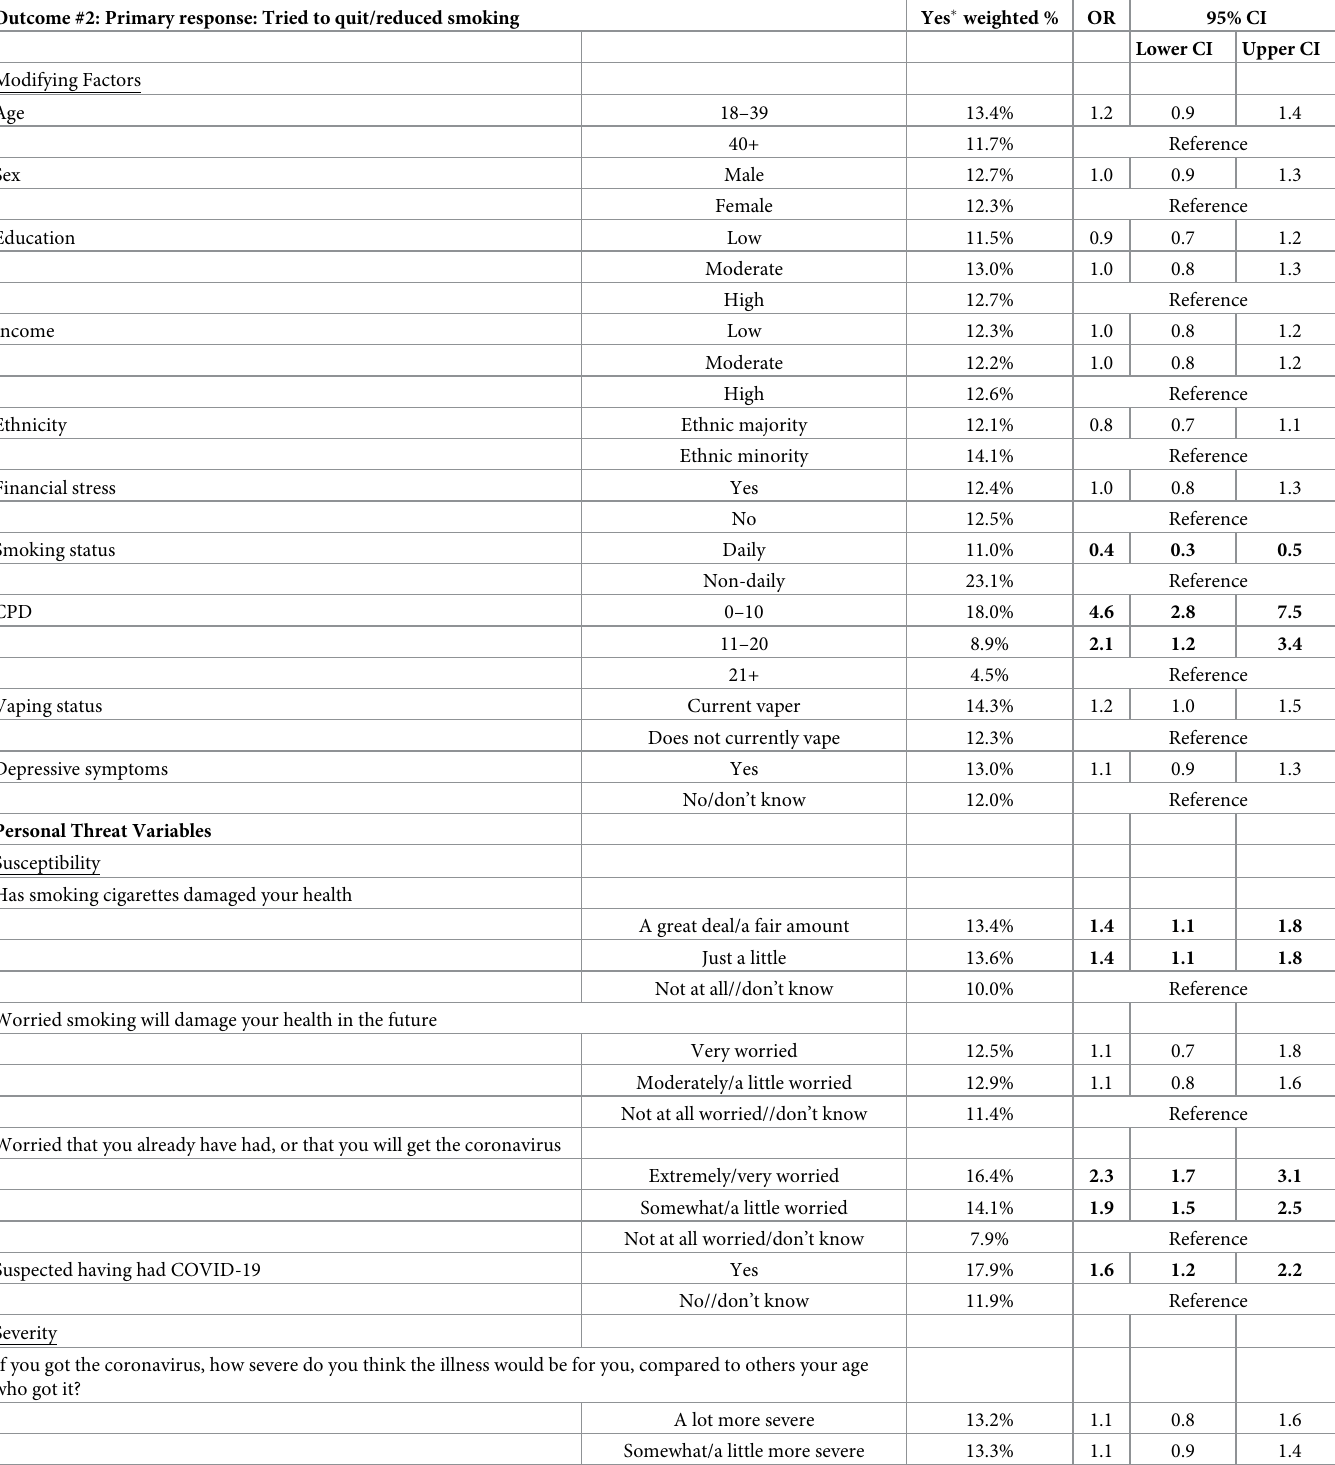
Table 5. Model 2: Regression analyses examining smokers’ positive behavioural change in smoking (reduced or tried to quit smoking) that occurred because of COVID-19. Outcome #2: Primary response: Tried to quit/reduced